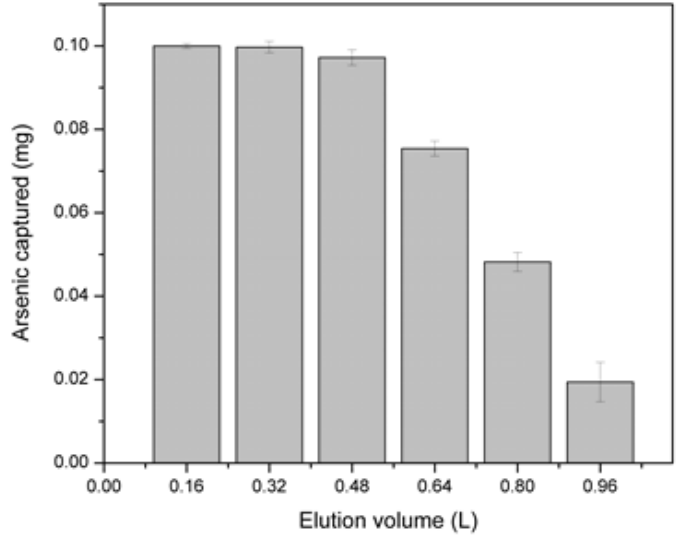
Figure 7. Affinity assays between Q/VTMSO-SiO 2 and arsenic solution (0.1 mg · L − 1